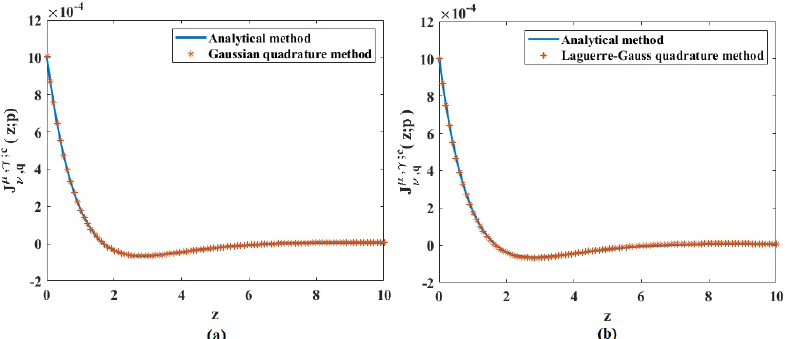
Figure 1. Comparison between the series and integral representations of J µ , γ ; c ν , q ( z ; p ) from ( a ) Equation (11) and ( b ) Equation